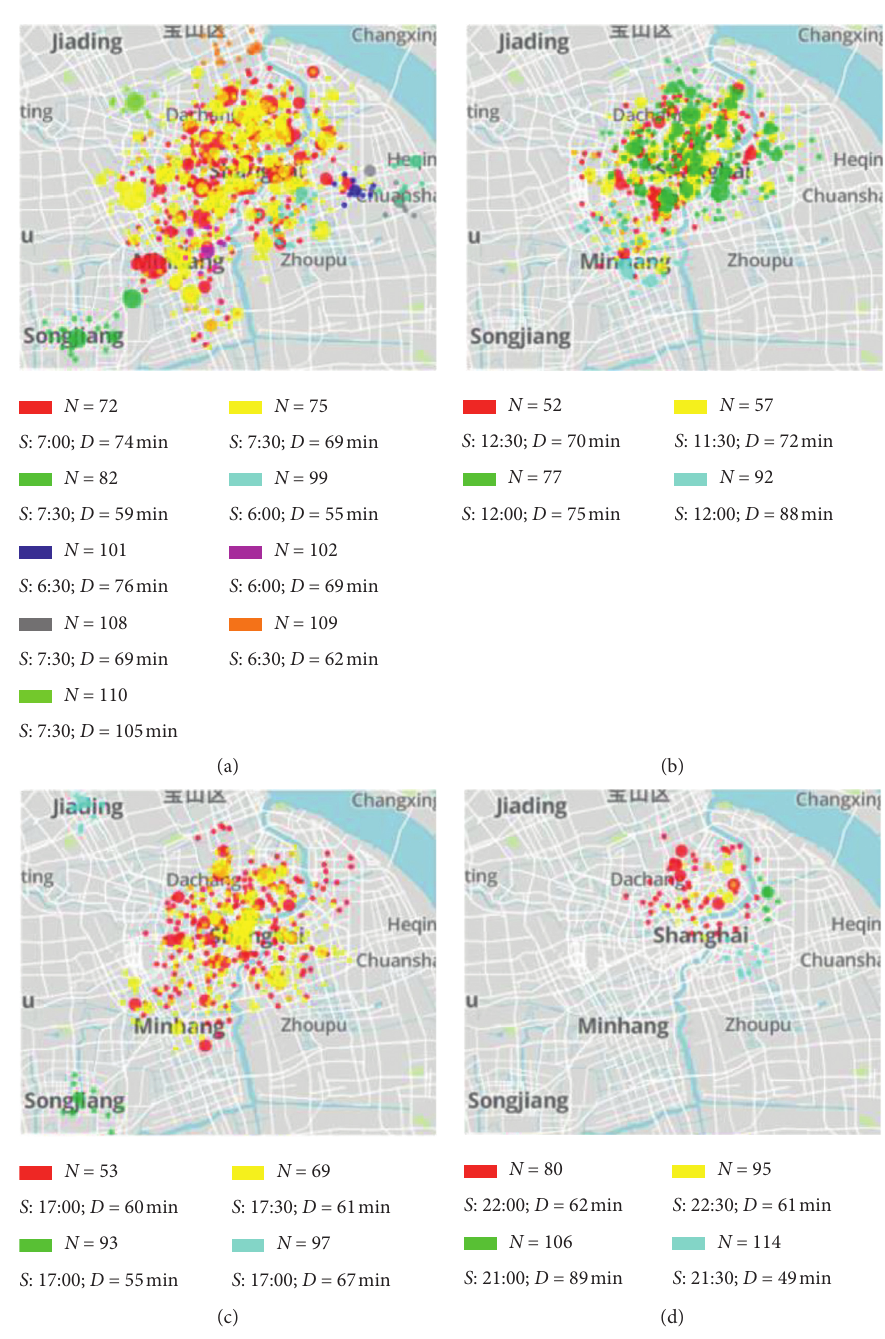
Figure 12: Sample activity pattern related to shopping. Size of the points represents the relative activity frequency. N : cluster number; S : start time; D : duration. (a) Work in the morning. (b) Work in the afternoon. (c) Work in the evening. (d) Long time work in the